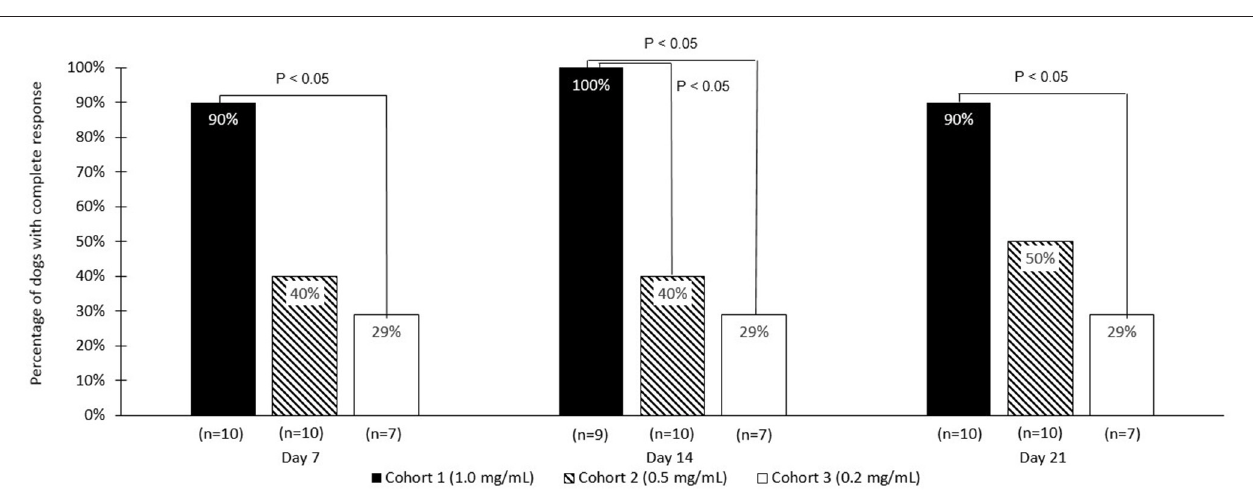
FIGURE 1 | Comparative complete response rate (based on RECIST criteria) for the three tigilanol tiglate dose cohorts at days 7, 14, and